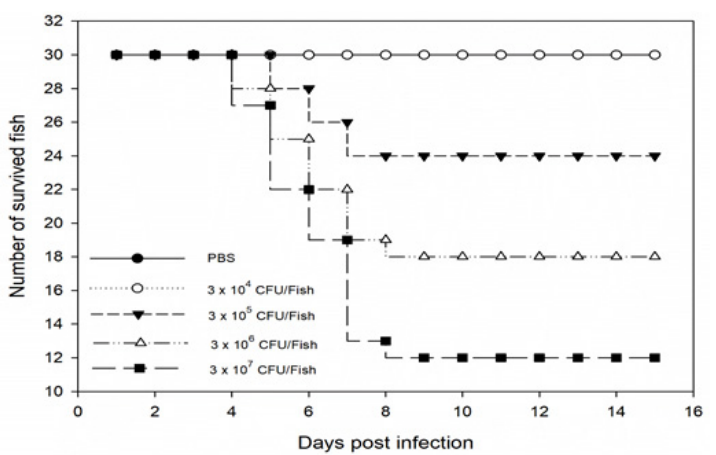
Figure 3. Challenge trial result showing the survival rate of the infected fish upon day post-infection.